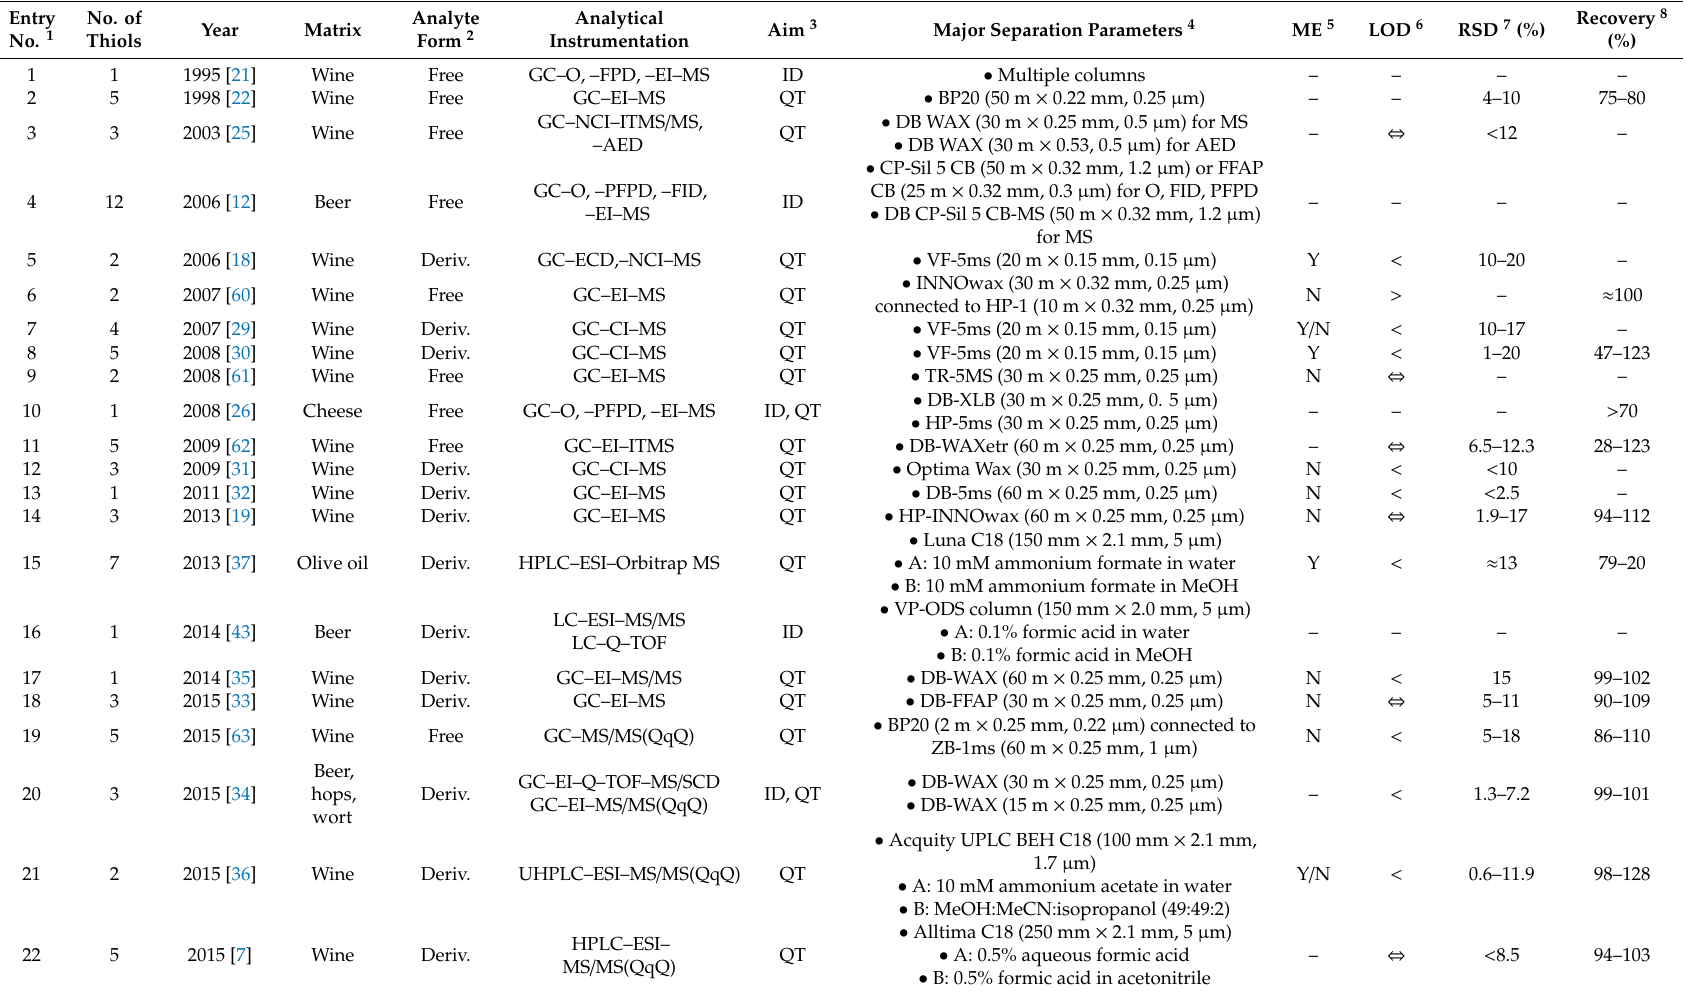
Table 2. Instrumental methods reported for potent volatile thiols in wine, foods, and other